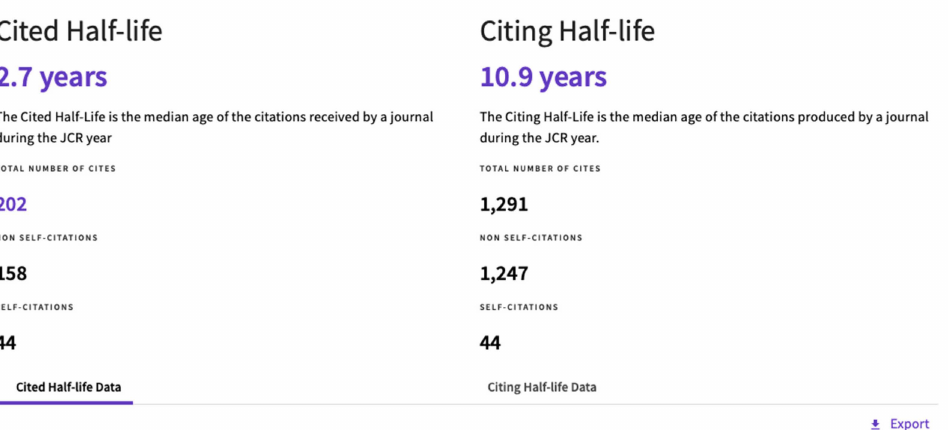
Figure 15. The ( left ) average age of the papers from the analysed journal cited in other journals and ( right ) the age of the papers cited in the analysed journal (2017–2019